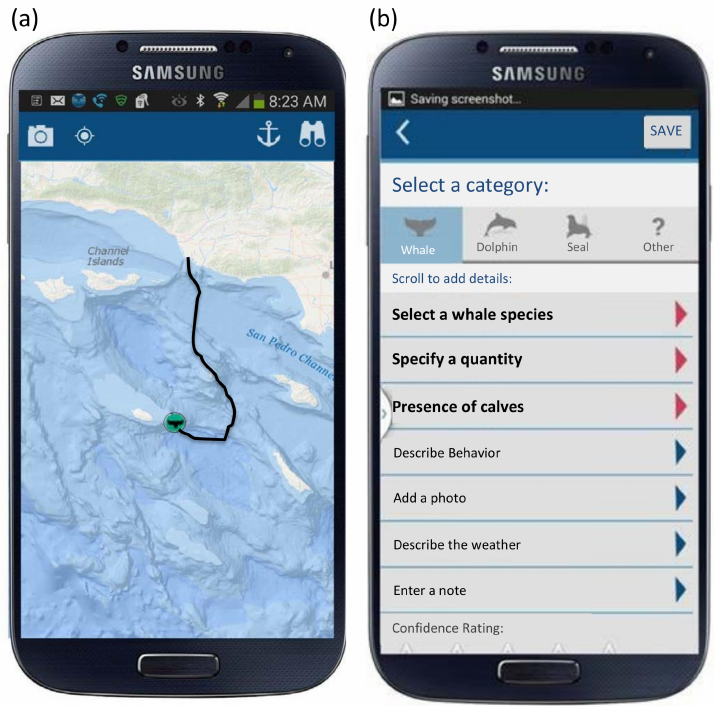
Figure 1. ( a ) Whale mAPP map display showing the map, track line, and sighting record icon; ( b ) Whale mAPP display for recording a marine mammal